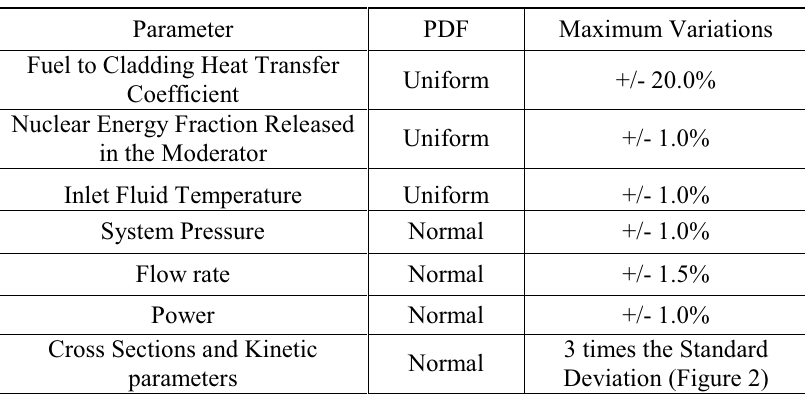
Table II. TH Uncertainties